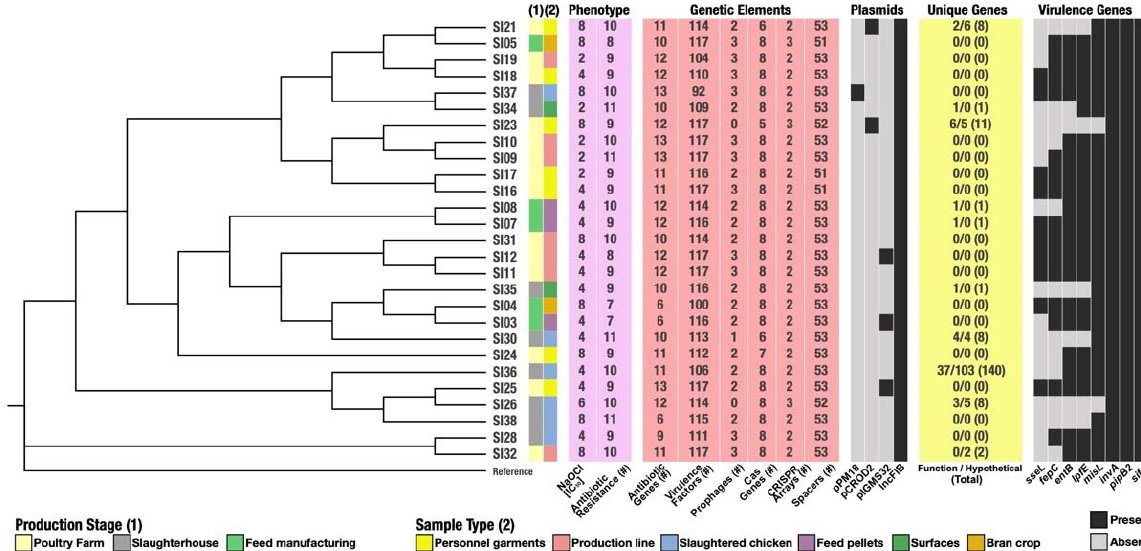
Figure 6. Schematic representation of the characteristics of the 27 S . Infantis strains. The organization is according to the SNP-based phylogeny and categorized by their production stage and sample type origins. The purple panel shows the number of antibiotics to which the corresponding strain is resistant and their IC 50 value against NaOCl. The pink panel shows the number of different genetic elements detected in the corresponding strain. The gray heatmaps represent the presence/absence pattern for known plasmids and genes of interest (virulence). Finally, the yellow panel shows the number of unique genes: those with functional annotation, those translating to hypothetical proteins and the total of unique genes, for the corresponding strain.